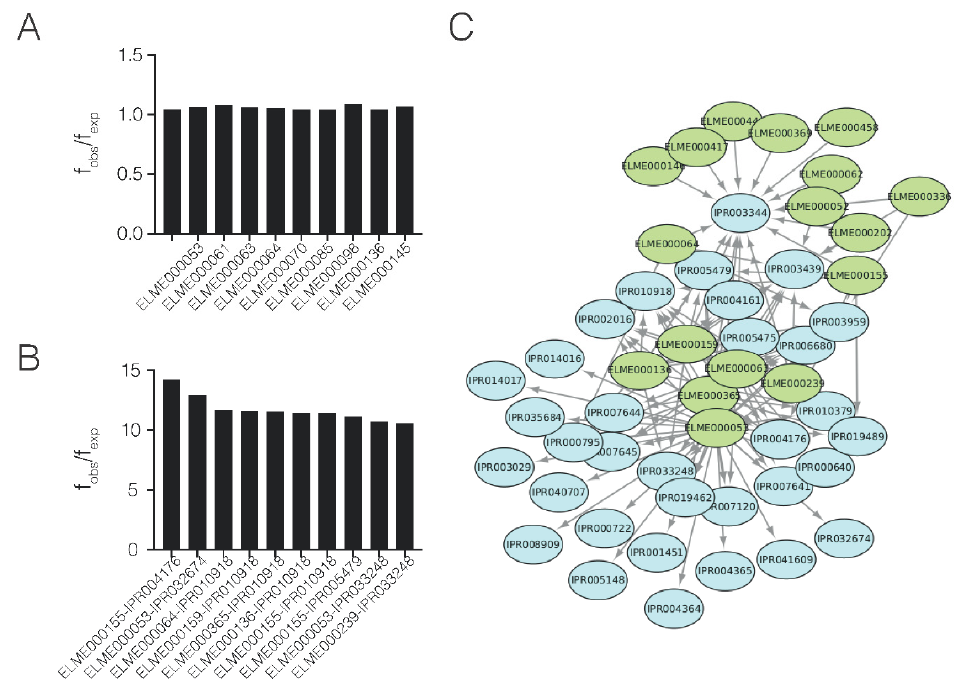
Figure 5. Analysis of enriched motifs and domain–motif associations. ( A ) Bar plot representation of the 10 most enriched motifs and ( B ) domain-motif combinations. ( C ) Network representation of domain–motif associations. Domains are colored in blue and motifs in green.